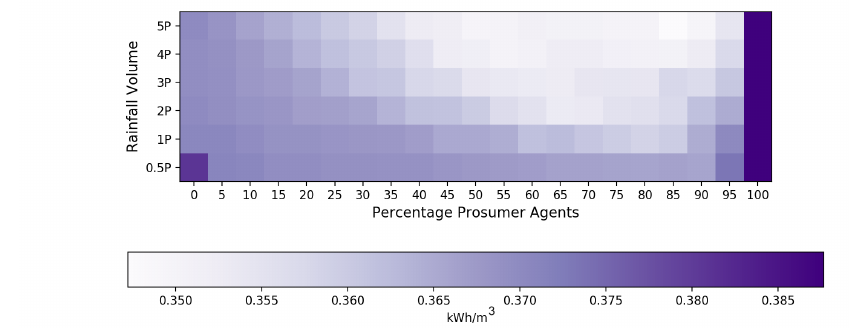
Figure 10. Energy consumed per unit volume of water produced. Energy is calculated as the sum of all three energy expenditures: household-level pumping, centralized pumping, and treatment. Produced water is calculated as the sum of water produced by the centralized system and the water produced by prosumer